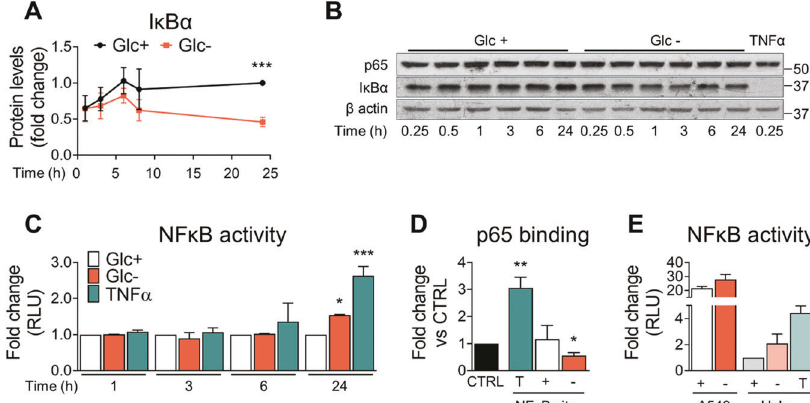
Fig. 3 NF- κ B regulates IL-8 production under basal and stimulated conditions. A A549 cells were treated with media with or without glucose (25 – 0 mM). Cells were collected at indicated time points to analyze p65 and I ĸ B ɑ by western blot. Results are shown compared to 24